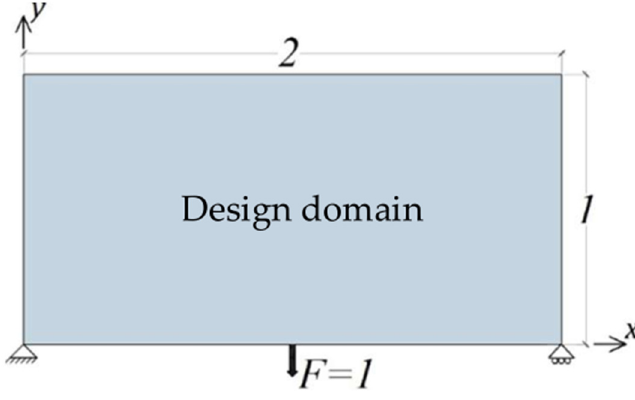
Figure 7. Problem definition of the pinned-roller plate: design domain, loading, and supports.